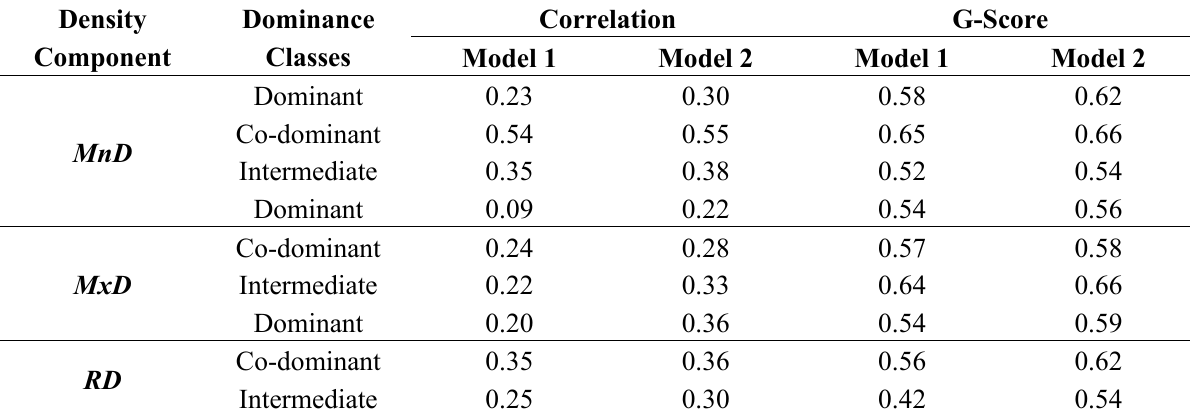
Table 6. Spearman’s correlation coefficient and g-score for observed and predicted density based on Model 1 (without climatic variables) and Model 2 (including climatic variables) for each wood density component and dominance class